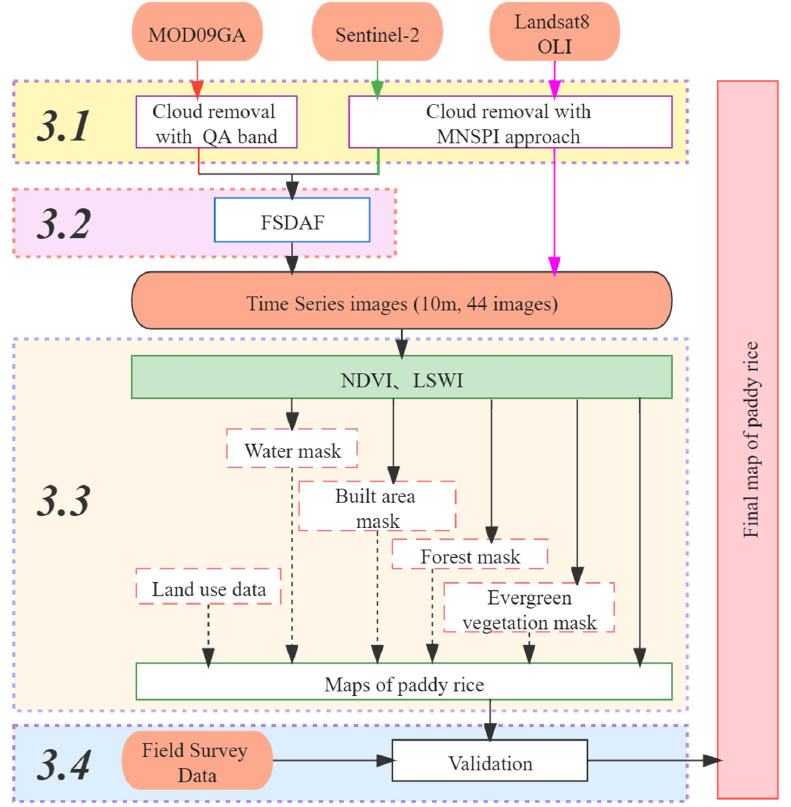
Figure 4. A flow chart of the algorithm for mapping paddy rice area.